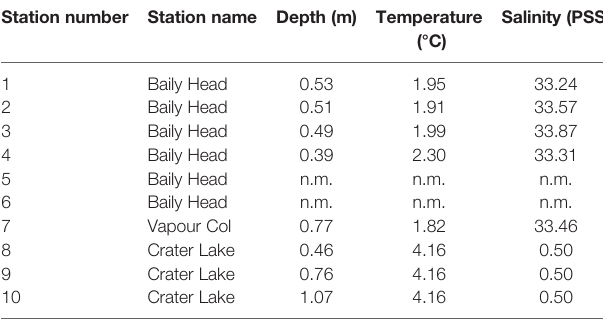
TABLE 4 | Ancillary parameters measured in-situ with multiparameter